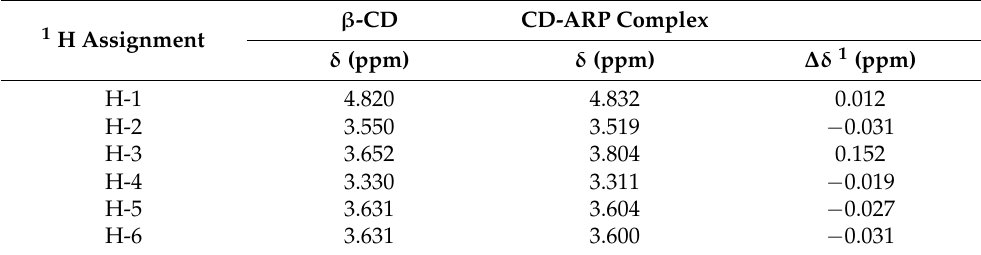
Figure 3. ( a ) Tautomeric forms of the Glu-Phe ARPs, ( b ) structure of β -CD showing the numbering of the β -glucose monomer, ( c ) ROESY spectrum of the CD-ARP complex and ( d ) possible CD-ARP complex mode. Table 1. Variation of proton chemical shift ( ∆ δ /ppm) of β -CD before and after forming complex with Glu-Phe